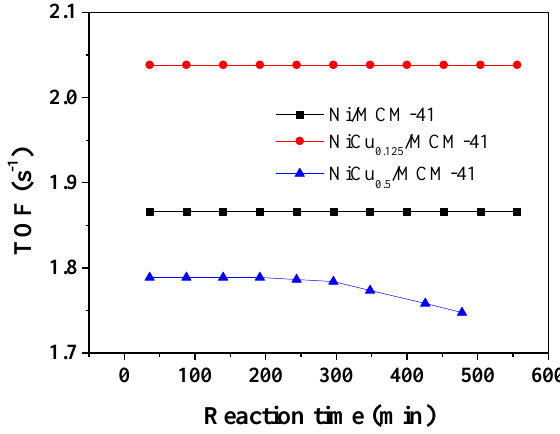
Figure 3. TOF value for the Ni/MCM-41, NiCu 0.125 /MCM-41 and NiCu 0.5 /MCM-41catalysts at 8000 mL·g −1 ·h −1 , 250 °C, and V(H 2 )/V(C 2 H 2 ) = 3.